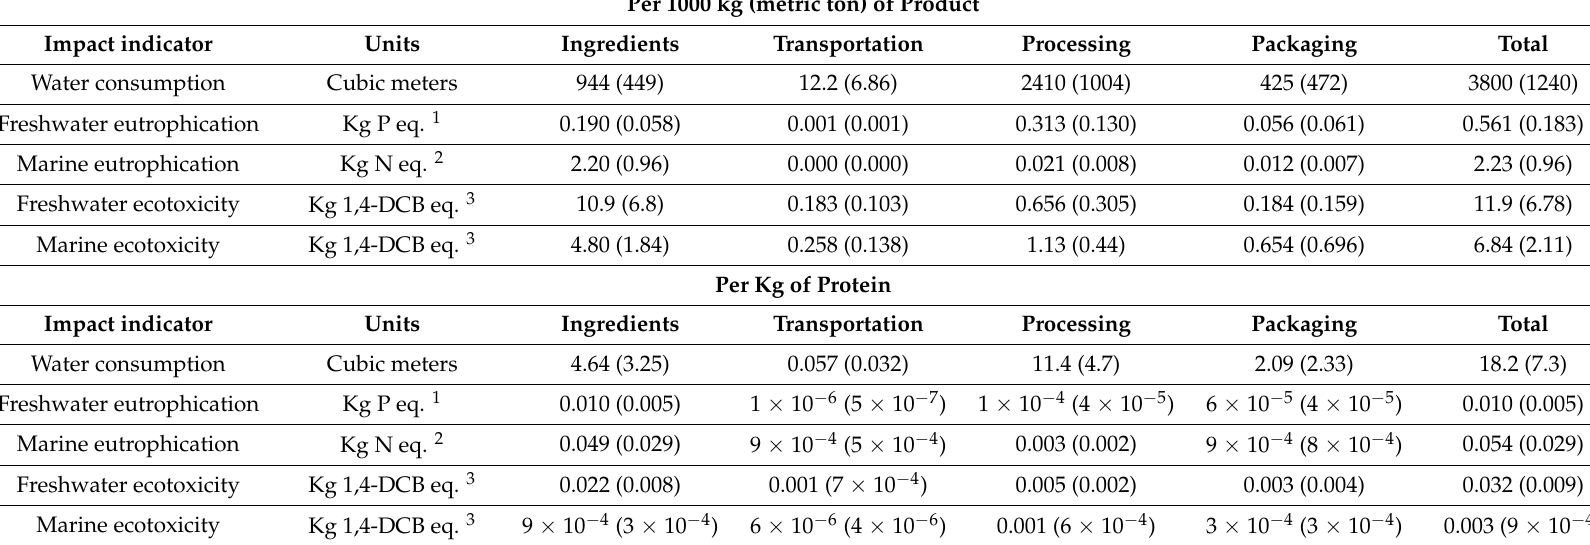
Table 2. Mean (standard deviation) of water-related impacts attributable to different phases of meat analog production. Data for impact categories are reported per 1000 kg (ton) of product and per kg of